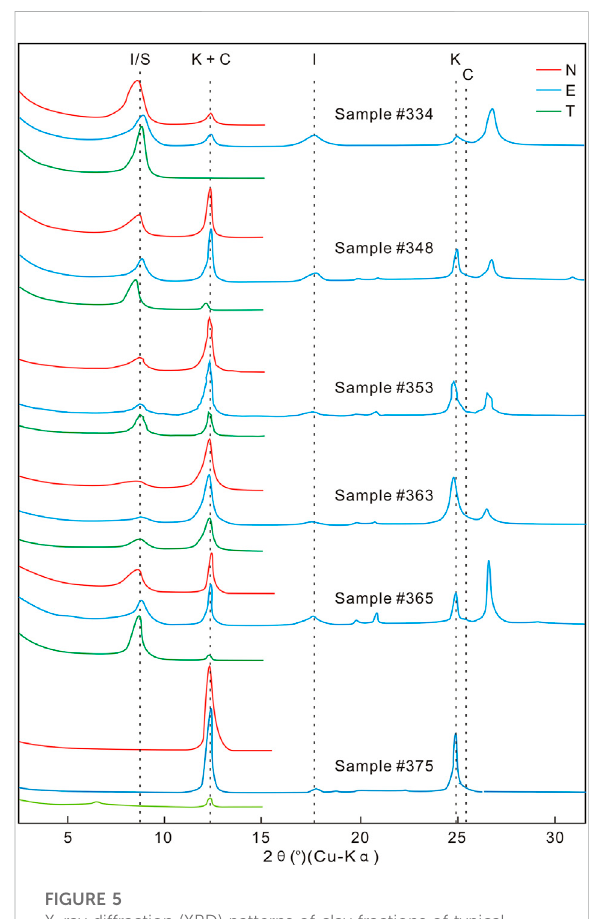
FIGURE 5 X-ray diffraction (XRD) patterns of clay fractions of typical samples in the study area. N, E, and T designate spectra of a naturally-orientedslide(redline),ethylene-glycolsaturatedforthe oriented slide (blue line), and high-temperature treated (green line) at 450 ° C for the oriented slide,